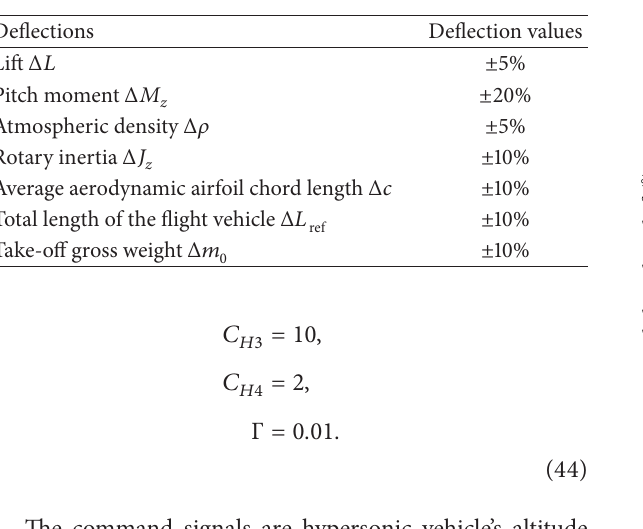
Table 4: The deflections and deflection values.